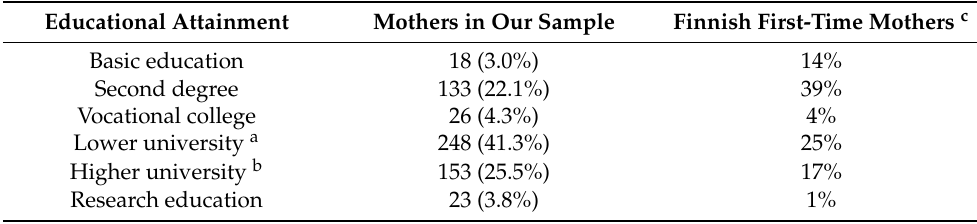
Table 1. Mothers’ Educational Level Compared to National